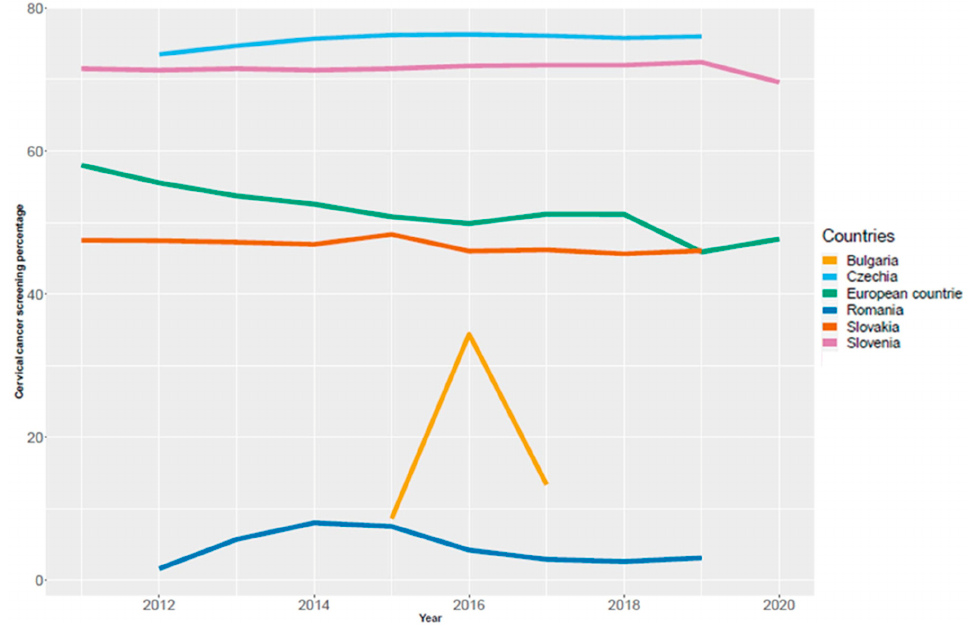
Figure 8. Coverage of Bulgarian population by screening program, 2013–2020 [20].